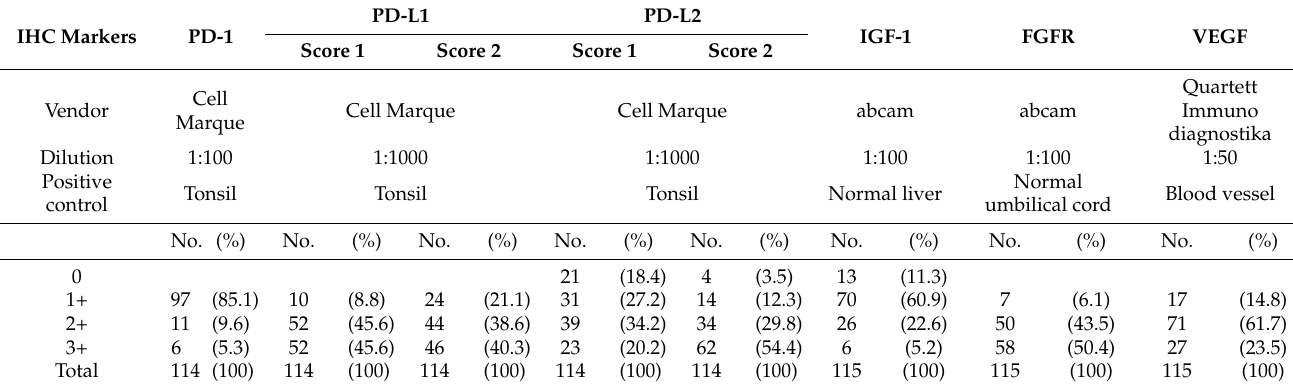
Table 3. Immunohistochemical staining conditions and the immunoreactivity of the immune checkpoint and EMT markers. IHC